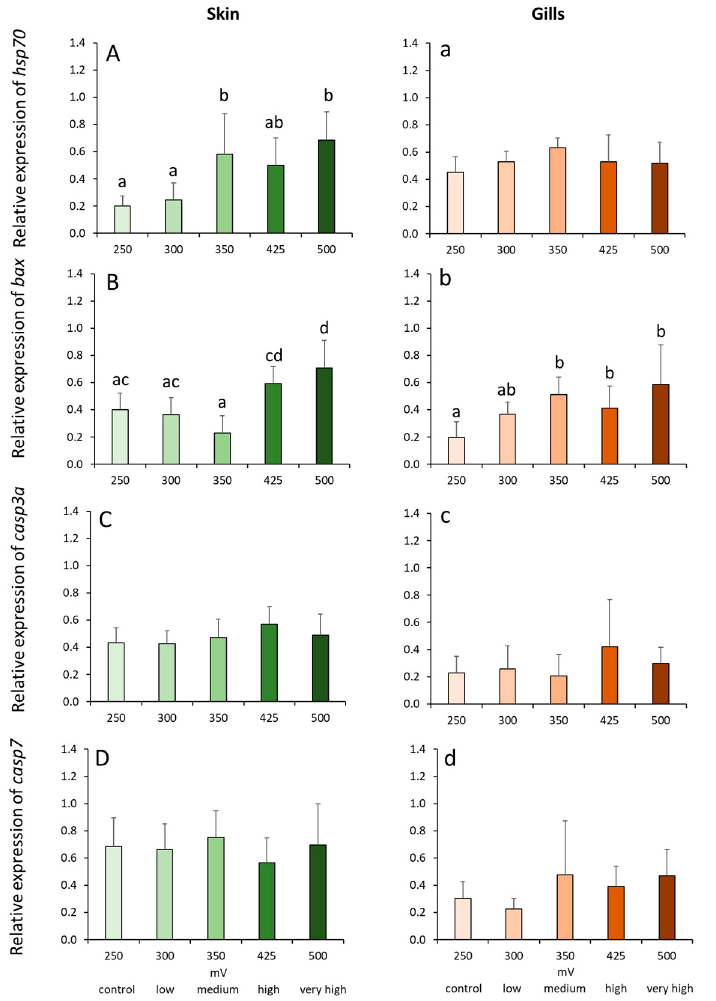
Figure 6. Relative expression of stress and apoptosis-related genes in the skin ( A – D ) and gills ( a – d ) of Atlantic salmon exposed to varying ORP levels. Values are presented as mean and standard deviation of 6 individual fish per treatment group. Di ff erent letters denote significant di ff erence between treatments at p < 0.05.